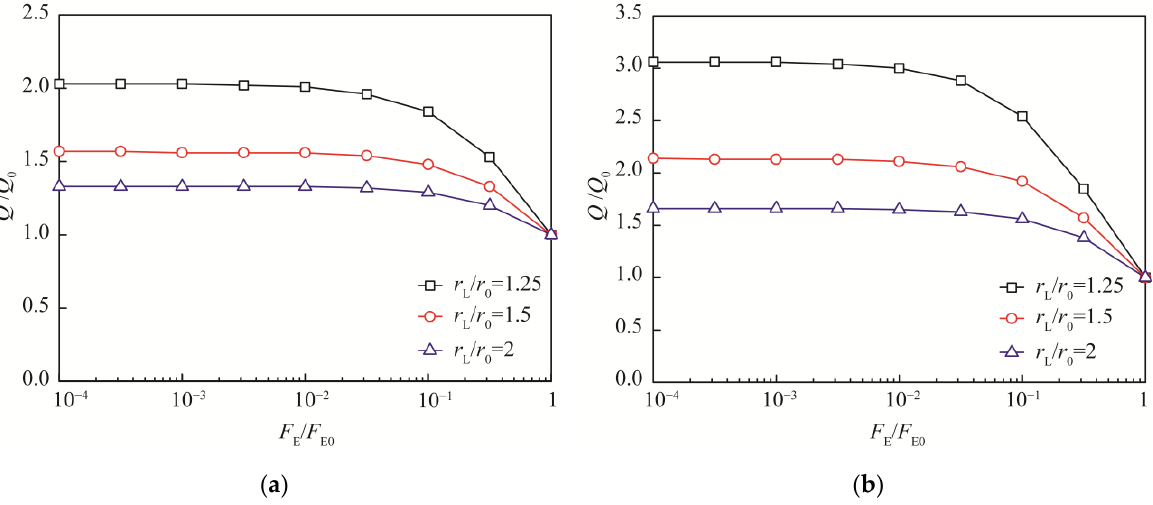
/ r r values. ( a ) L 0 / Q Q with different k and / r r values. 0 / Q Q with different / h r , L 0 k and / r r values. 0 L R L 0